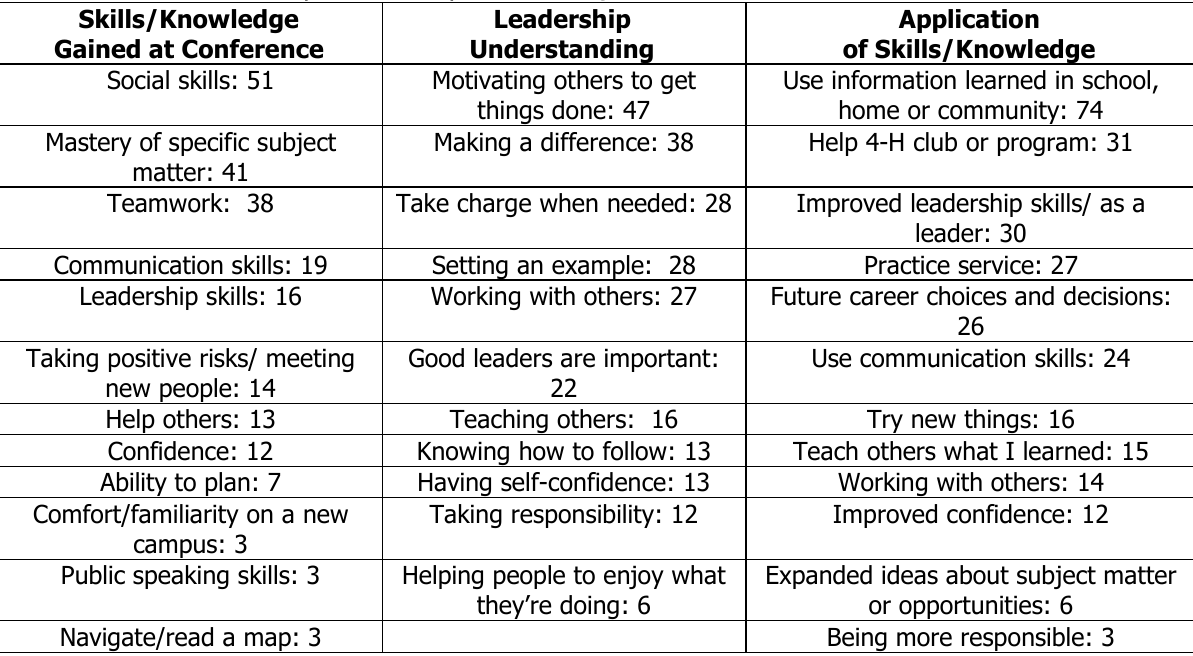
Summarized Responses to Open-ended Questions for Iowa 4-H Youth Conference